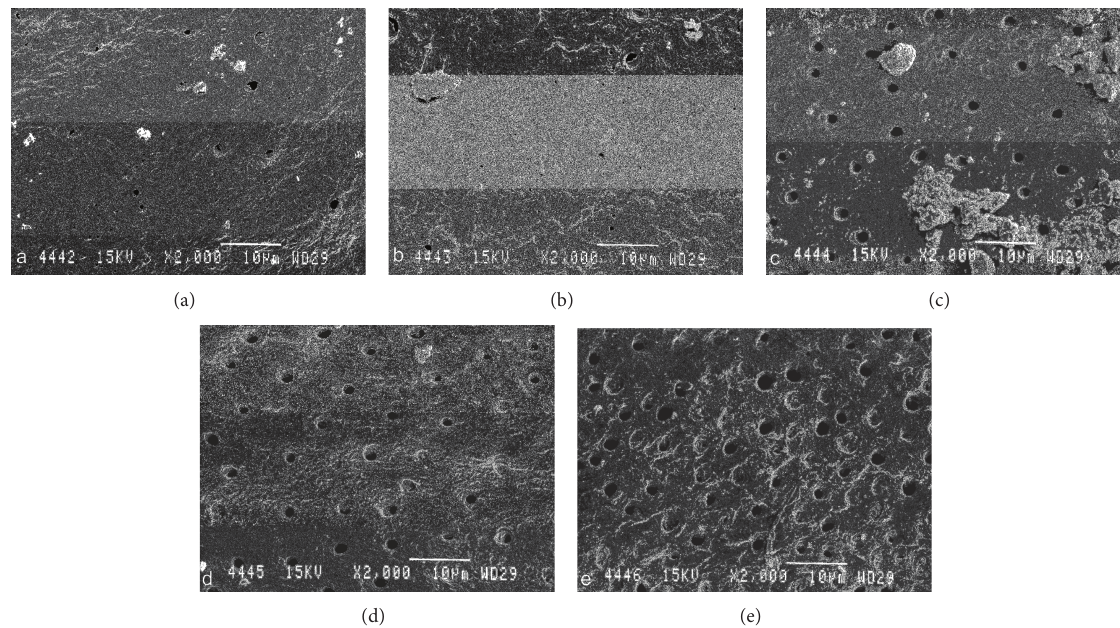
Figure 4: Photomicrographs of root canal wall in each group after final cleaning protocols (original magnification: 2000x; scalebar is 10 𝜇 m). Images (a)–(e) show canal walls at 1, 3, 6, 8, and 12mm from the apex. In groups 3 and 8, smear layer removal was observed at 6, 8, and 12mm, though less extensive than in groups 2 and 7 (Figure 3) and 4 and 9 (Figure 5). (a) is at 1mm from the apex, (e) is at 12 mm from the apex.